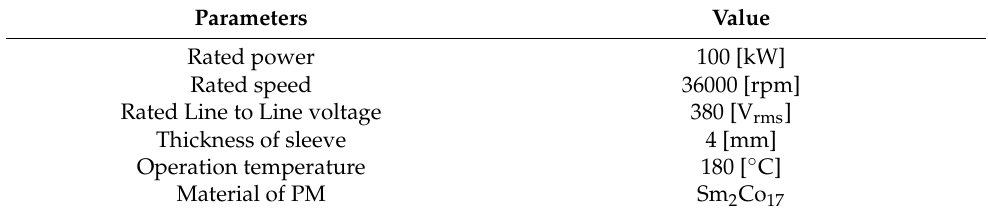
Figure 1. Shape of high-speed generator according to shaft material. Furthermore, a sleeve was used to prevent the PM from scattering as it rotated at high-speed, and Inconel 718 material was used for the sleeve [15,16]. Table 1 shows the design requirements of the generator. Table 1. Design requirement